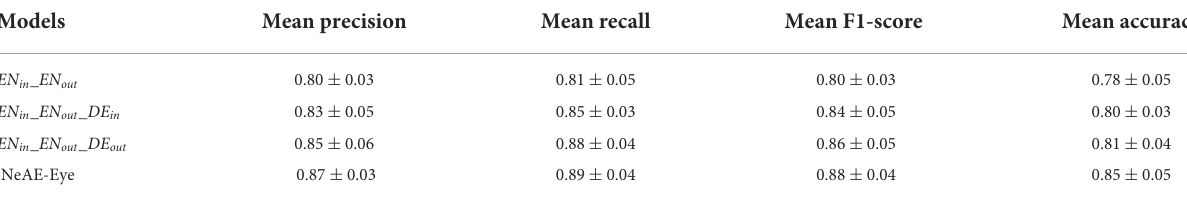
TABLE 2 Ablation experiment for the proposed NeAE-Eye model.